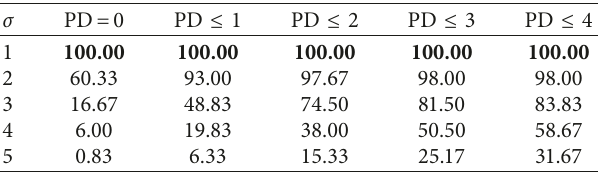
Figure 3: Image deblurring and matching results of the example, where the standard deviation of the Gaussian blur kernel is 3. (a) PD (matching). (b) Confidence (matching). (c) PSNR (deblurring). (d) SSIM (deblurring). Table 1: Image matching results of the SR-PIXEL method. Table 2: Image matching results of the SR-BI